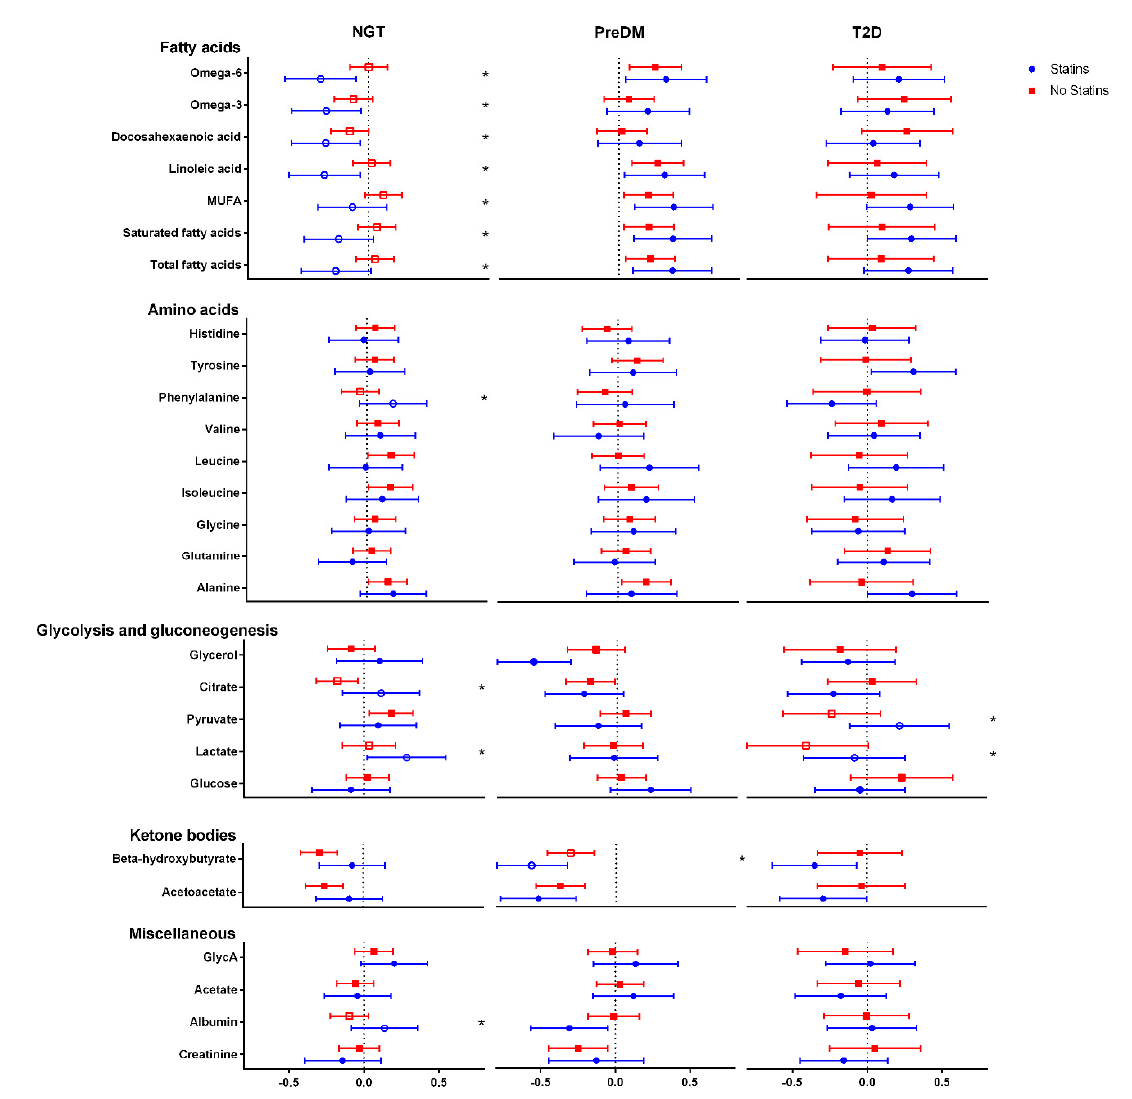
Figure 3. Associations between plasma NMR free fatty acids and other metabolites, and Proprotein convertase subtil- isin/kexin type 9 (PCSK9) in normal glucose tolerance (NGT), prediabetes (PreDM) and type 2 diabetes (T2D) subjects. n = 608, regression coefficients shown, * ≤ 0.05. MUFA, Monounsaturated fatty acid